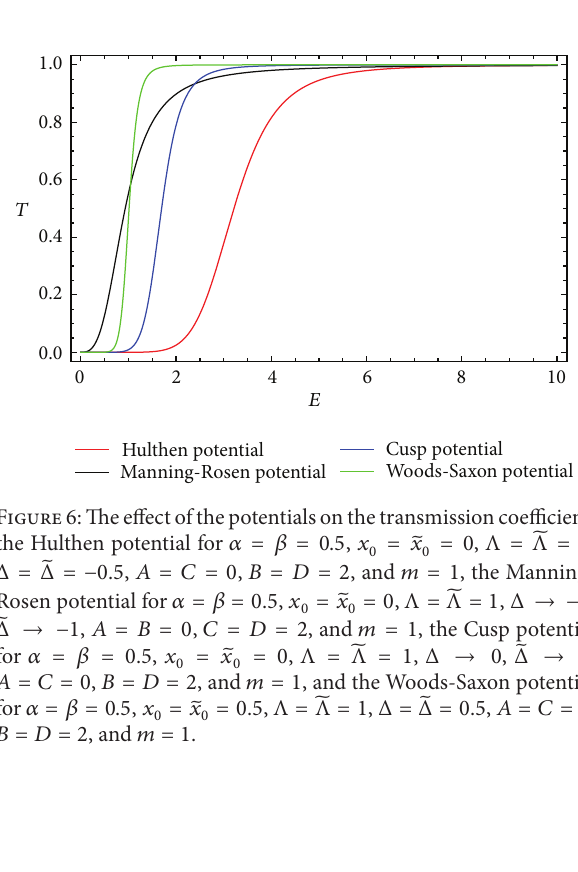
Figure 4: The effect of the GAMAR type potential parameters ( Δ, the 𝛼𝑥 0 , 𝛽̃𝑥 0 ). (a) shows 𝑇 for varying 𝐸 with 𝛼 = 𝛽 = 10 , 𝑥 0 = 2 , ̃𝑥 0 = 3 , Λ = 𝛼 = 𝛽 = 10 , 𝑥 = 2 , ̃𝑥 = 3 , Λ = ̃Λ = 1 , 𝐴 = 𝐵 = 𝐶 = 𝐷 = 𝑉 𝑉 0 with 0 0